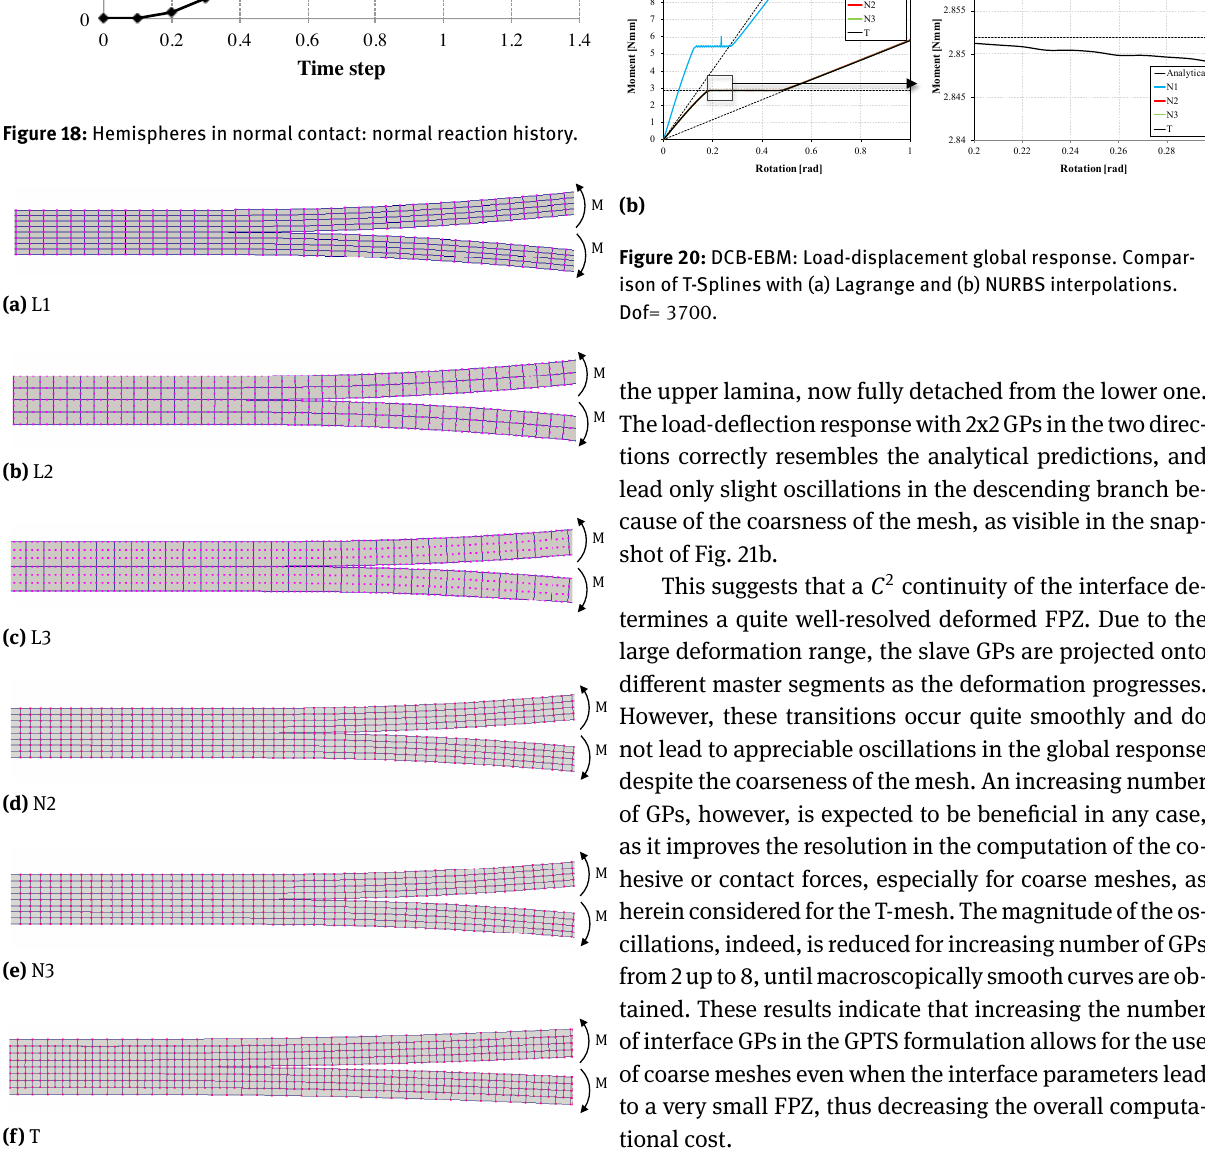
Figure 19: DCB-EBM: (a) Lagrange, (b) NURBS, and (c) T-Spline inter- polations. Dof = 3700 .